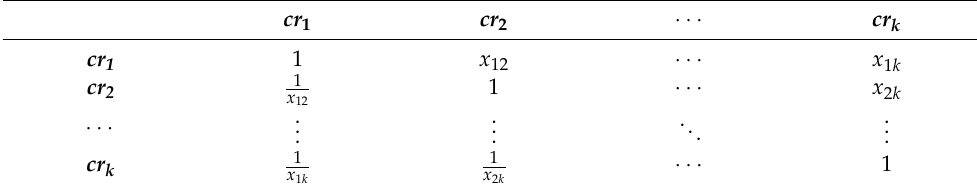
Table 5. Pair-wise Comparison Matrix